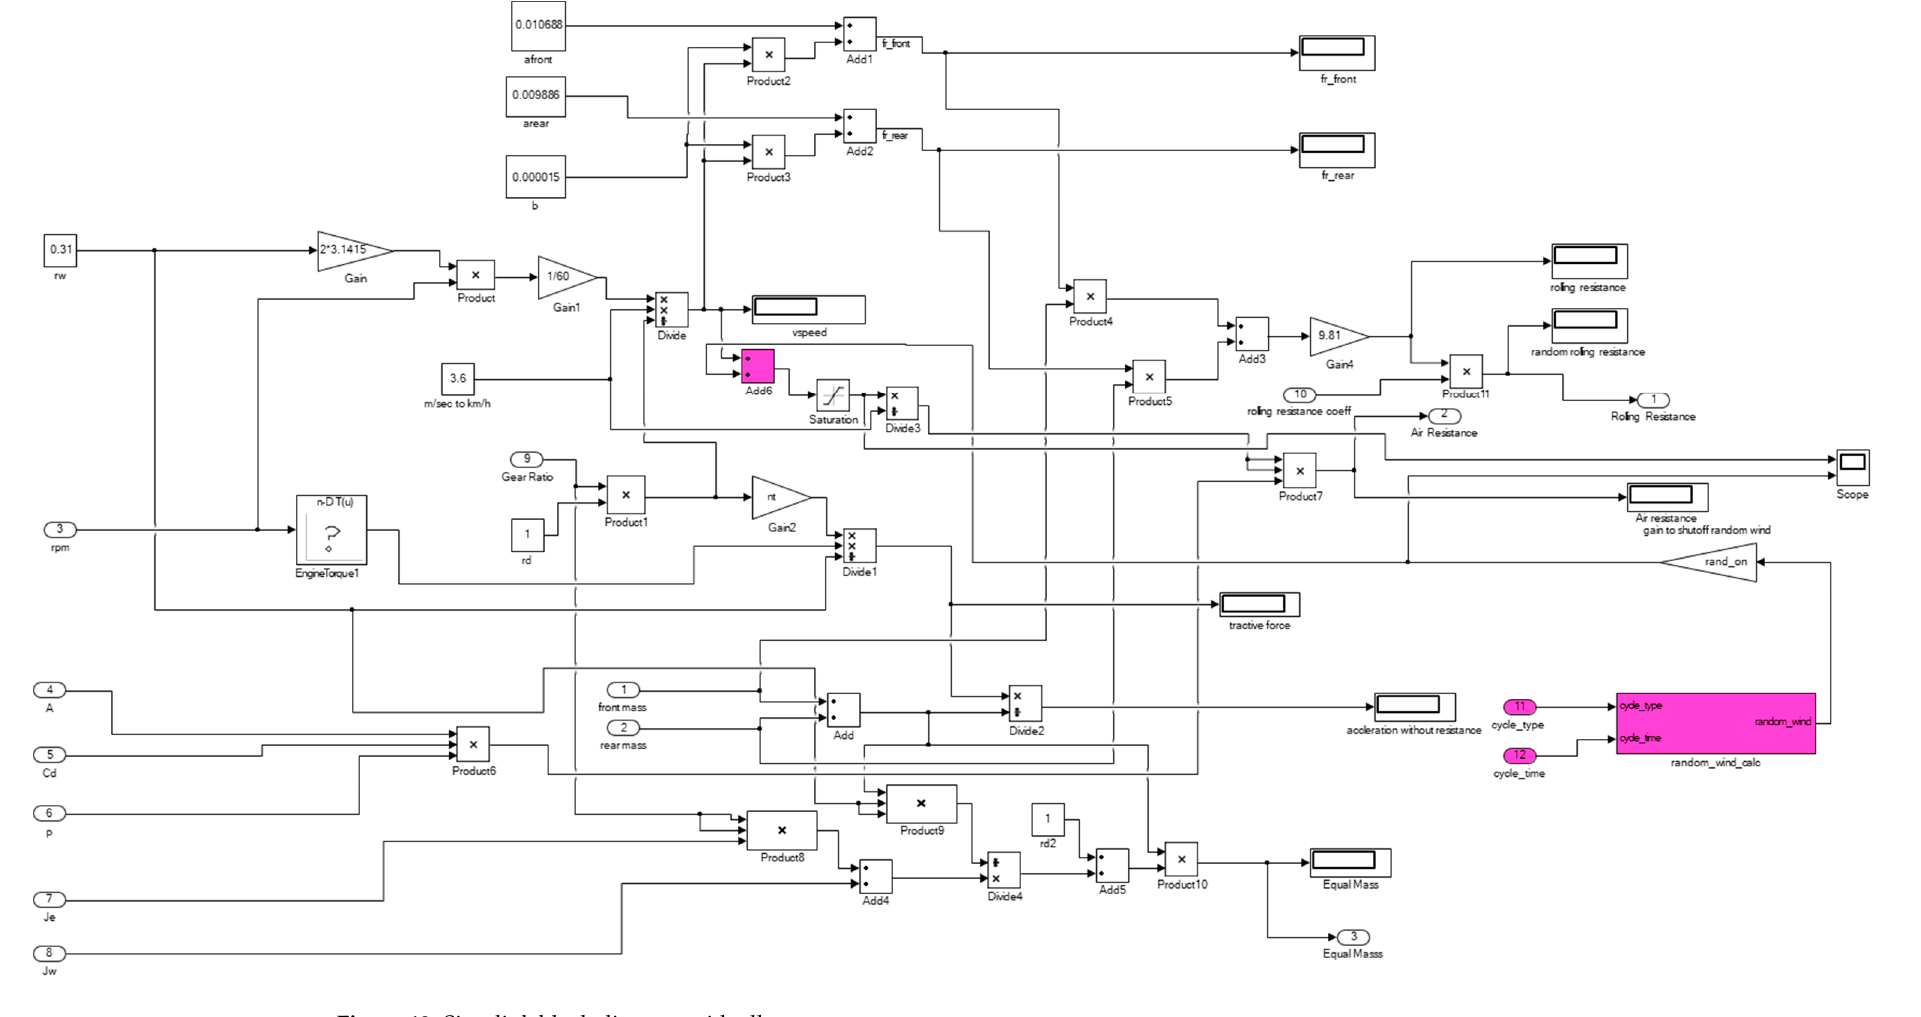
Figure 13. Simulink block diagram with all parameters.